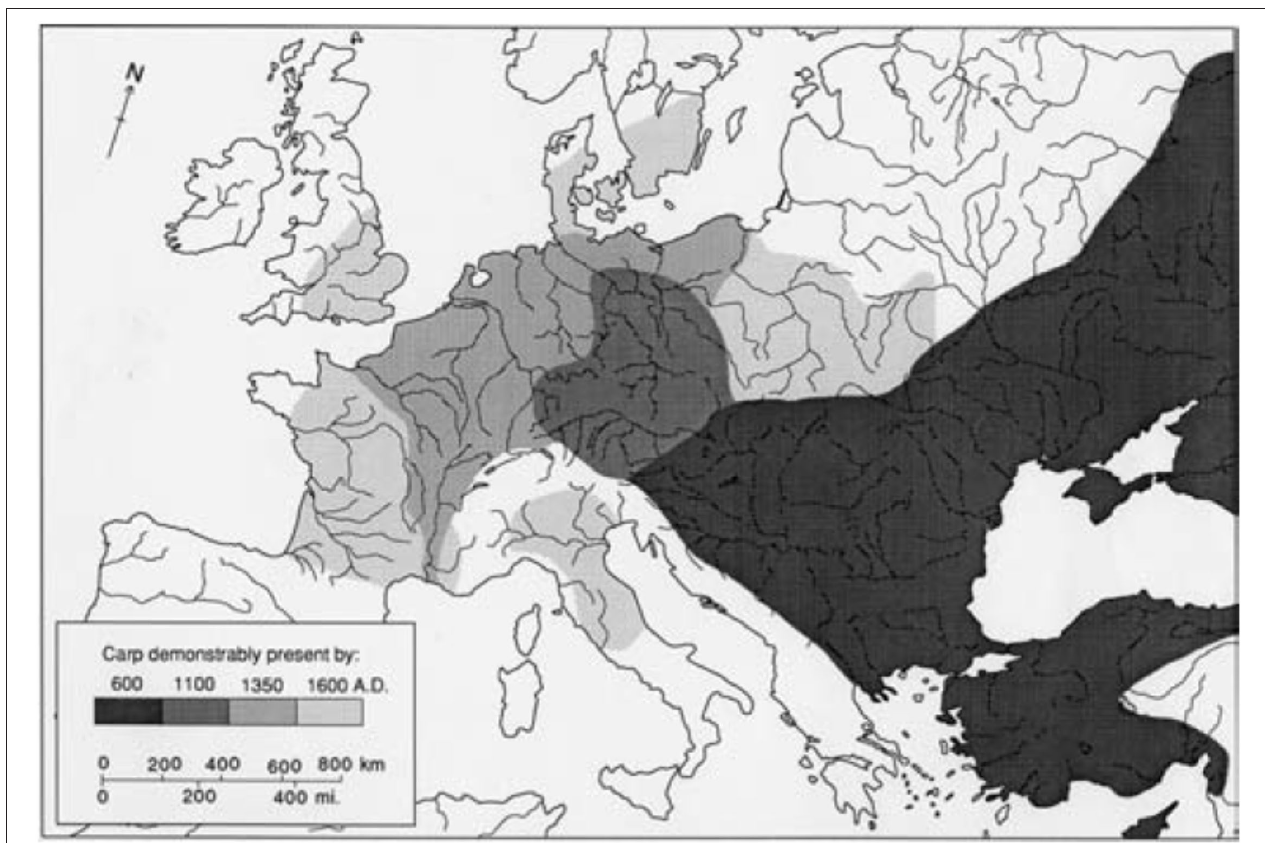
FIGURE 4 | Expansion of carp aquaculture over 1,000 years from natal river regions of southeastern Europe northwest to reach the British Isles and Scandinavia. From Hoffmann (2005). Reproduced with permission from the author (R. C.